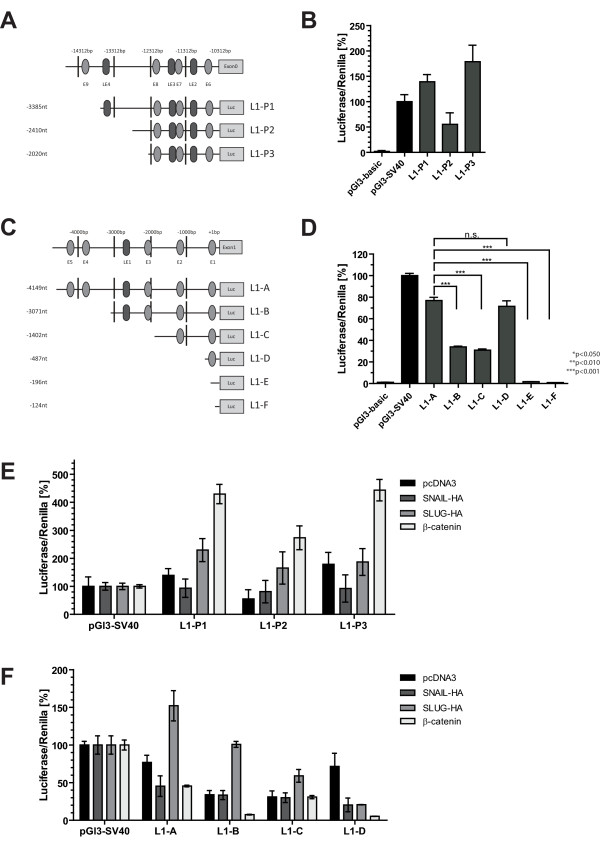
Luciferase reporter assays for L1CAM promoter 1 and promoter 2. (A and B) Schematic illustration of luciferase promoter constructs of variable length. The E-boxes (E1-E9) and LEF-1 binding sites (LE1-LE4) have been labelled in a consecutive fashion and are indicated. Note that the constructs contain variable number of E-boxes and LEF-1 binding sites and are referred to as L1-P1 to L1-P3 (from promoter 1) and A-F (from promoter 2). (C and D) Luciferase activity assay in Ishikawa cells using the indicated promoter constructs. Values have been normalized to the internal control (renilla) to account differences in transfection efficiency. The pGl3 vector was used as negative control and pGl3-SV40 as positive control. Luciferase activity was determined after 48 h. A representative experiment from each n = 4 is shown. (E) Luciferase activity assay of promoter 1 reporter constructs L1-P1 to -P3 in Ishikawa cells using the indicated constructs in combination with overexpression of Snail-HA, Slug-HA, stabilised β-catenin or pcDNA3 negative control. (F) Luciferase activity assay of promoter 2 reporter constructs A-D in Ishikawa cells using the indicated constructs in combination with overexpression of Snail-HA, Slug-HA, stabilised β-catenin or pcDNA3 negative control. Data ± SD of a representative experiment from n = 3 is shown. (*** p ≤ 0.001, **p ≤ 0.01, *p ≤ 0.05, n.s. not signicicant).